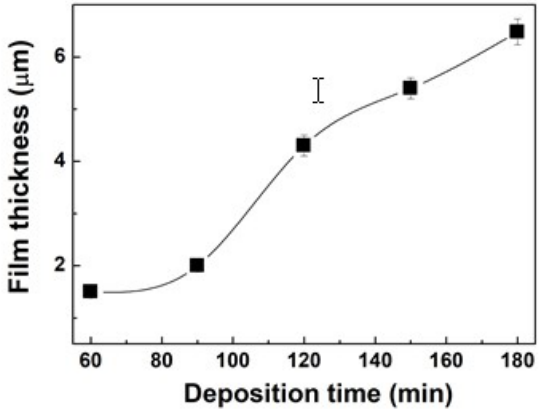
Figure 5. Variation in the film thickness of pPMMA thin films grown on glass substrates when using the proposed APP polymerization technique at different deposition times.